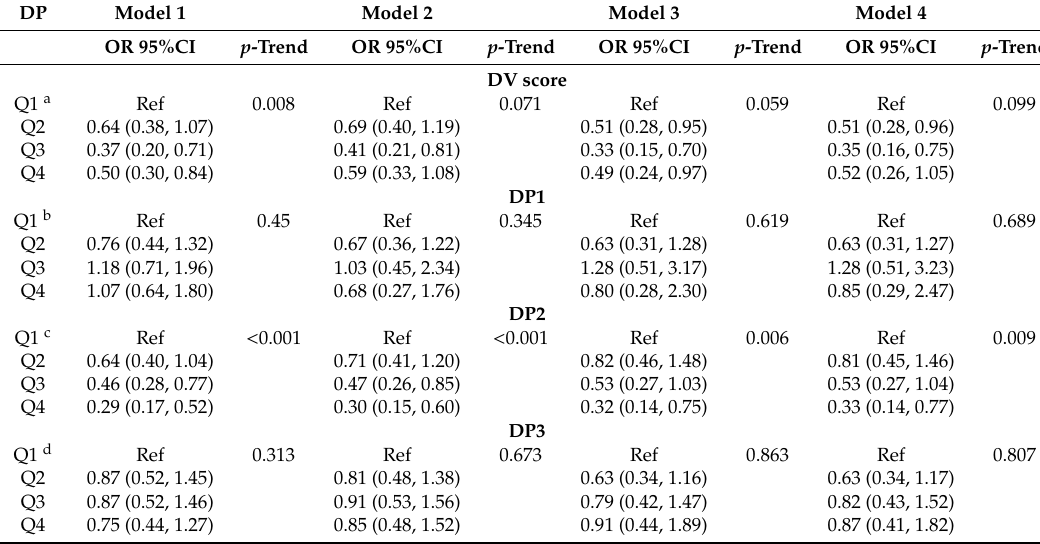
Model 1: Crude model. Model 2: adjusted by age, gender, and region. Model 3: adjusted by age, gender, region, BMI, exercise activity, lifestyle, and total dietary energy. Model 4: adjusted by age, gender, region, BMI, exercise activity, lifestyle, total dietary energy, smoke status, status of NCDs. a DV score ranged from 3 to 20; Q1 (3~9), Q2 (10~13), Q3 (14~16), Q4 (17~20). b DP1 score ranged from − 3.41 to 4.67; Q1 ( − 3.41~ − 0.75), Q2 ( − 0.74~ −